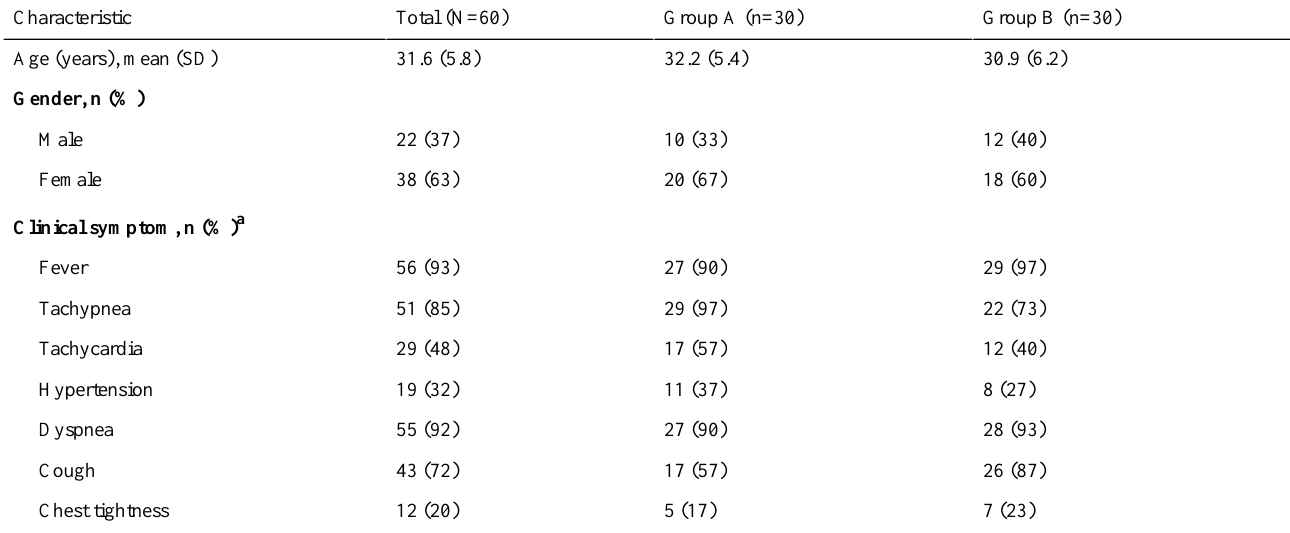
Table 1. Demographics and baseline characteristics of patients.